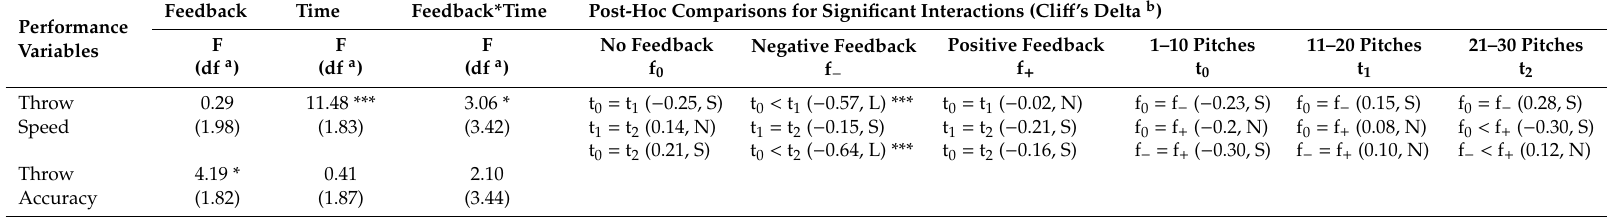
Table 2. Non-parametric repeated measures ANOVA-type models of performance variables for feedback, time of measure and their interaction, and post-hoc comparisons.